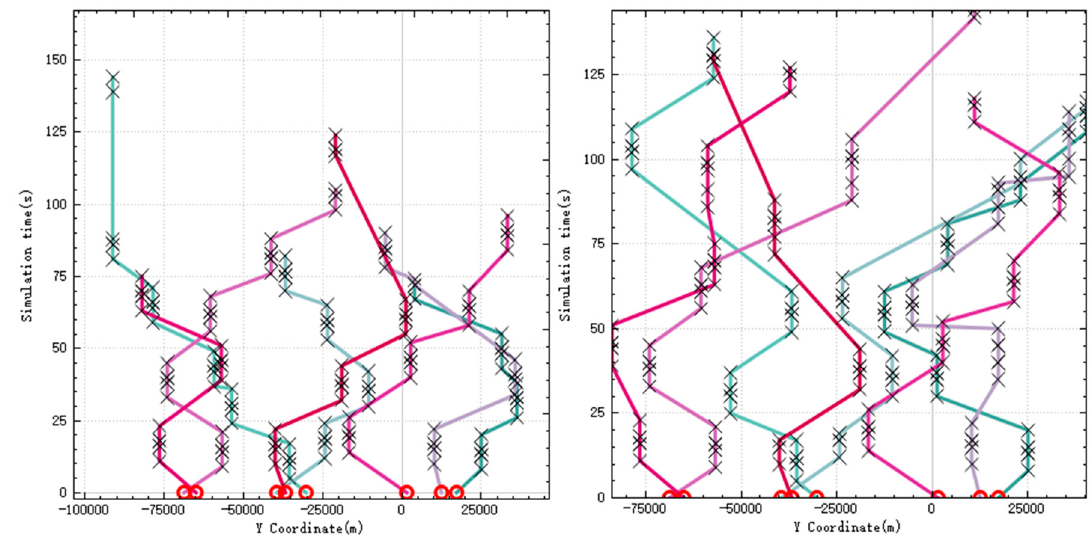
Figure 8. UAVs’ Y coordinate over time.